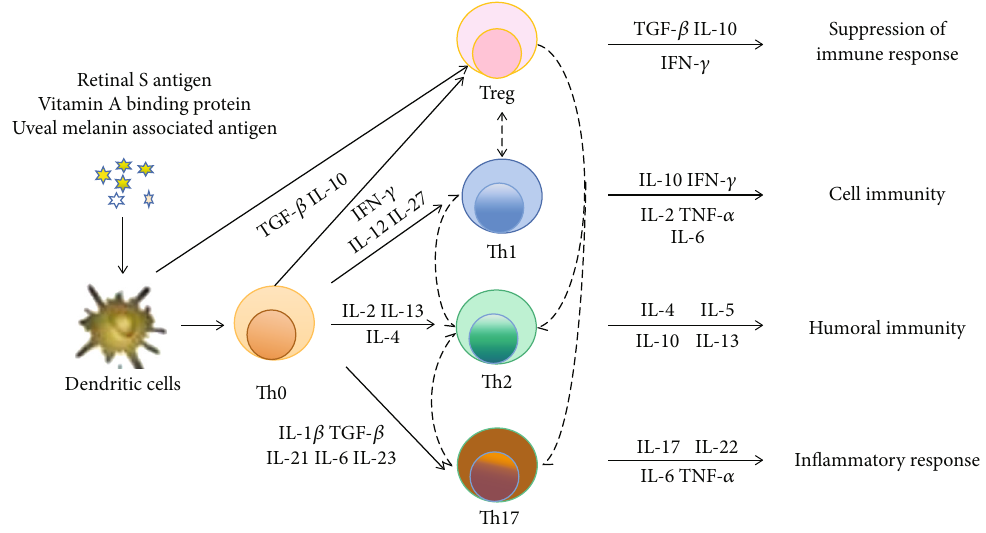
Figure 1: T lymphocytes and related immune responses in